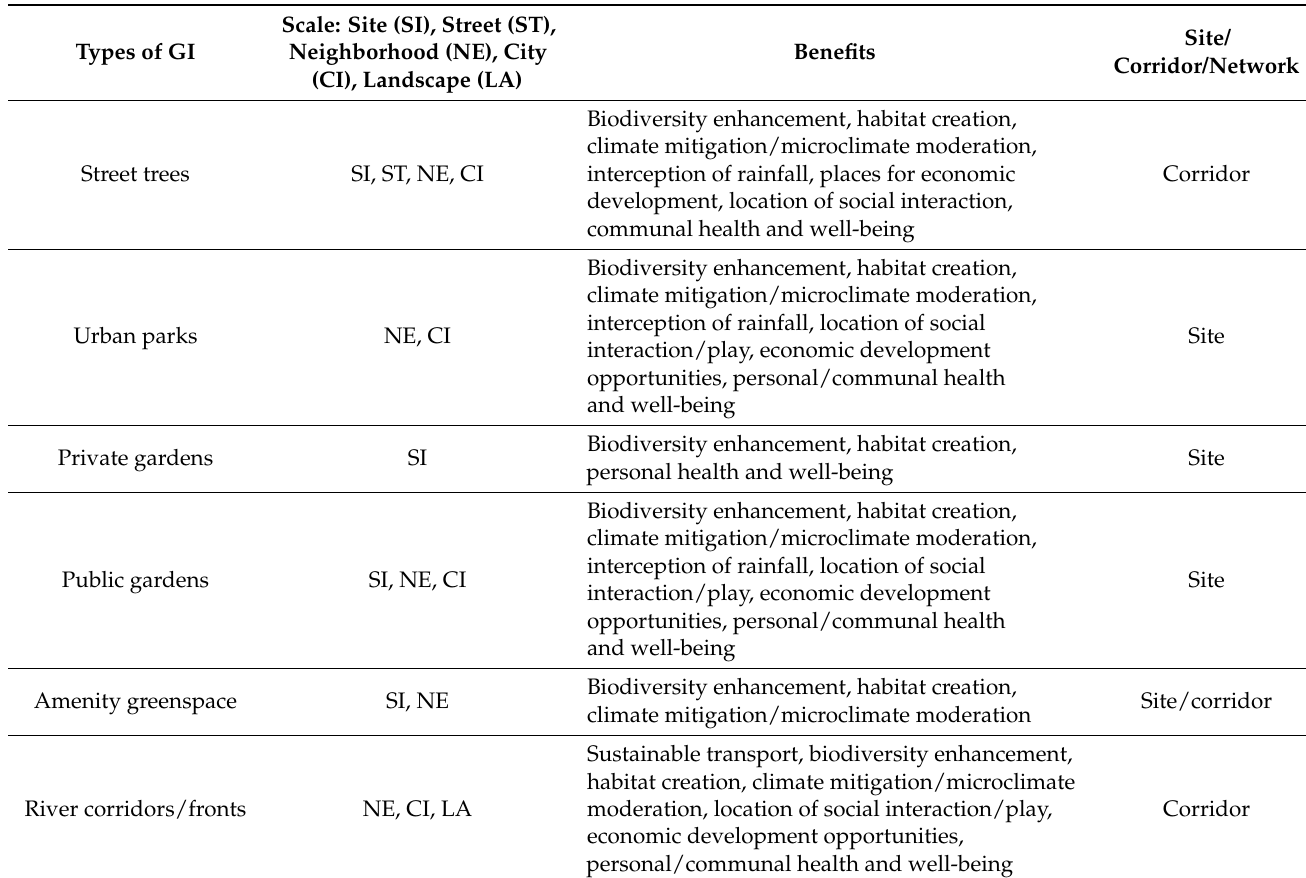
Table 1. Green infrastructure (GI)